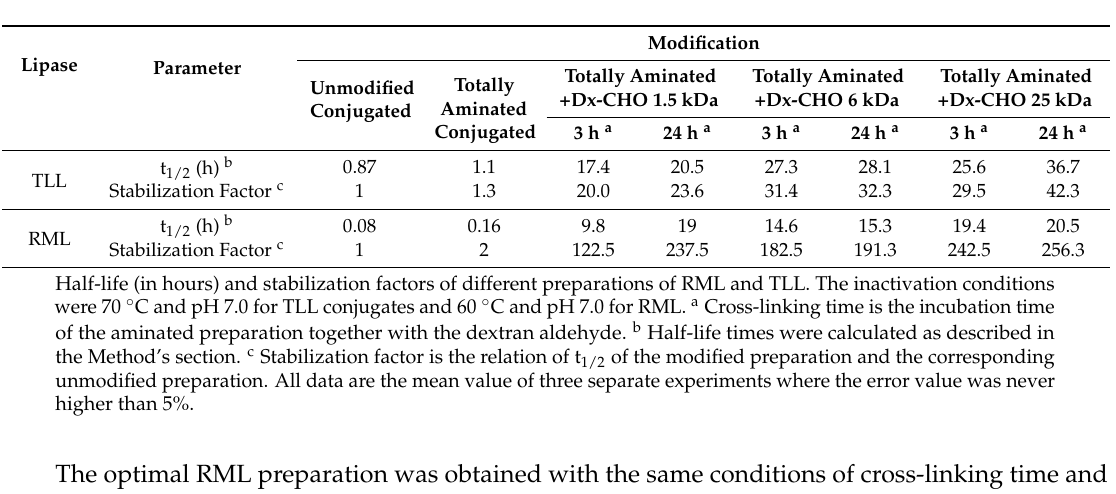
Table 3. Half-life and stabilization factors of the different lipase cross-linked